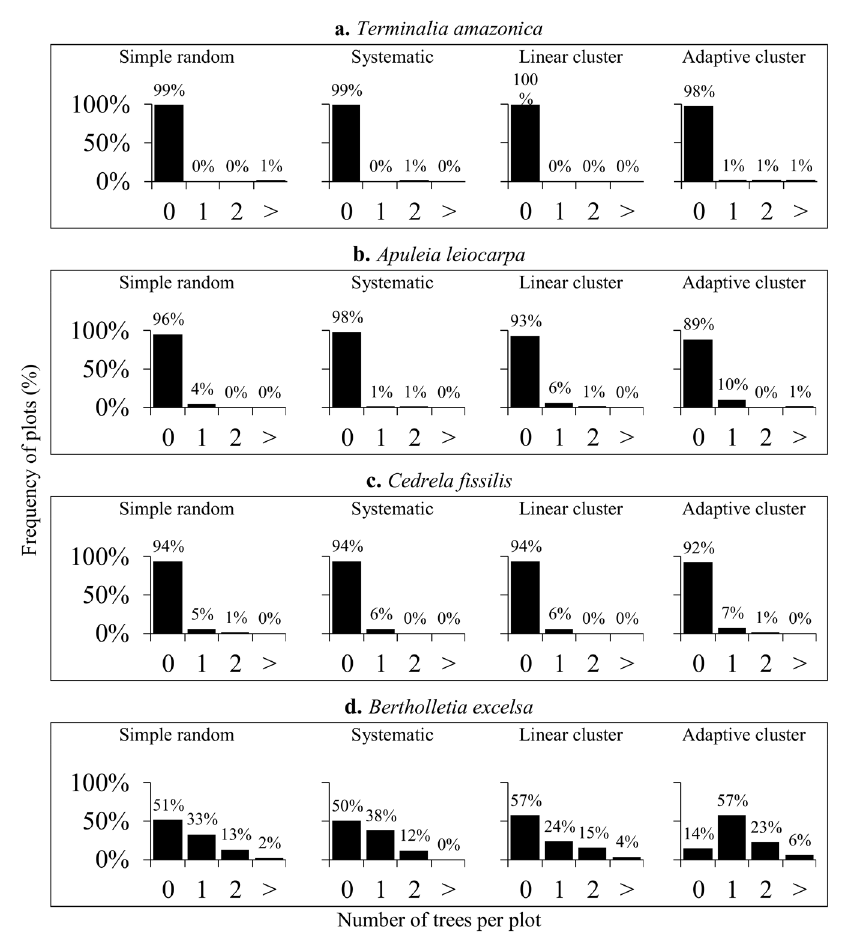
Figure 3 - Frequency of plots with zero, one, two or more than two trees for each species and sampling procedure in Jamari National Forest, Brazilian